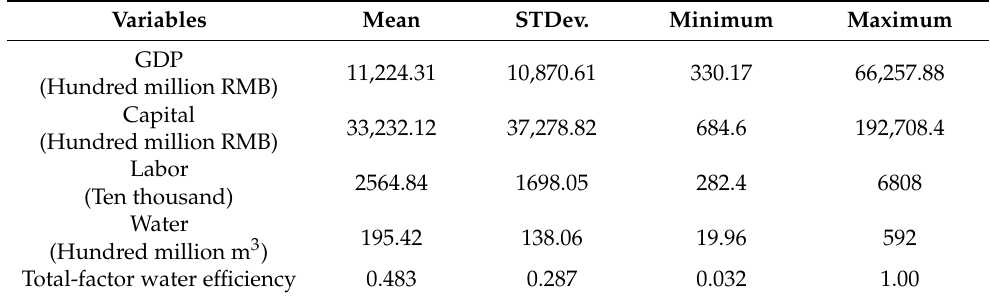
Table 1. Variables description.